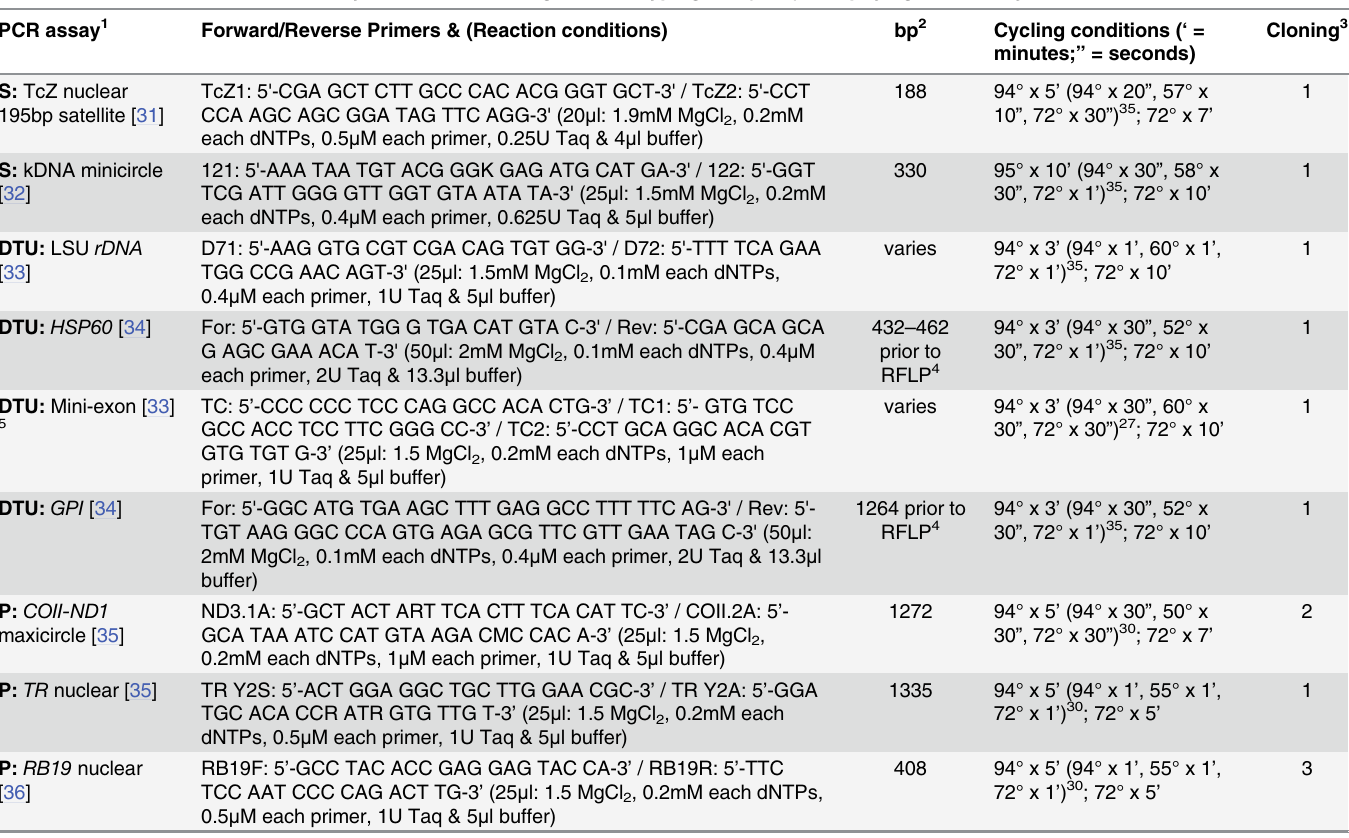
Table 1. Trypanosoma cruzi PCR assays used for screening, discrete typing unit (DTU), and phylogenetic analyses. PCR assay 1 Forward/Reverse Primers & (Reaction